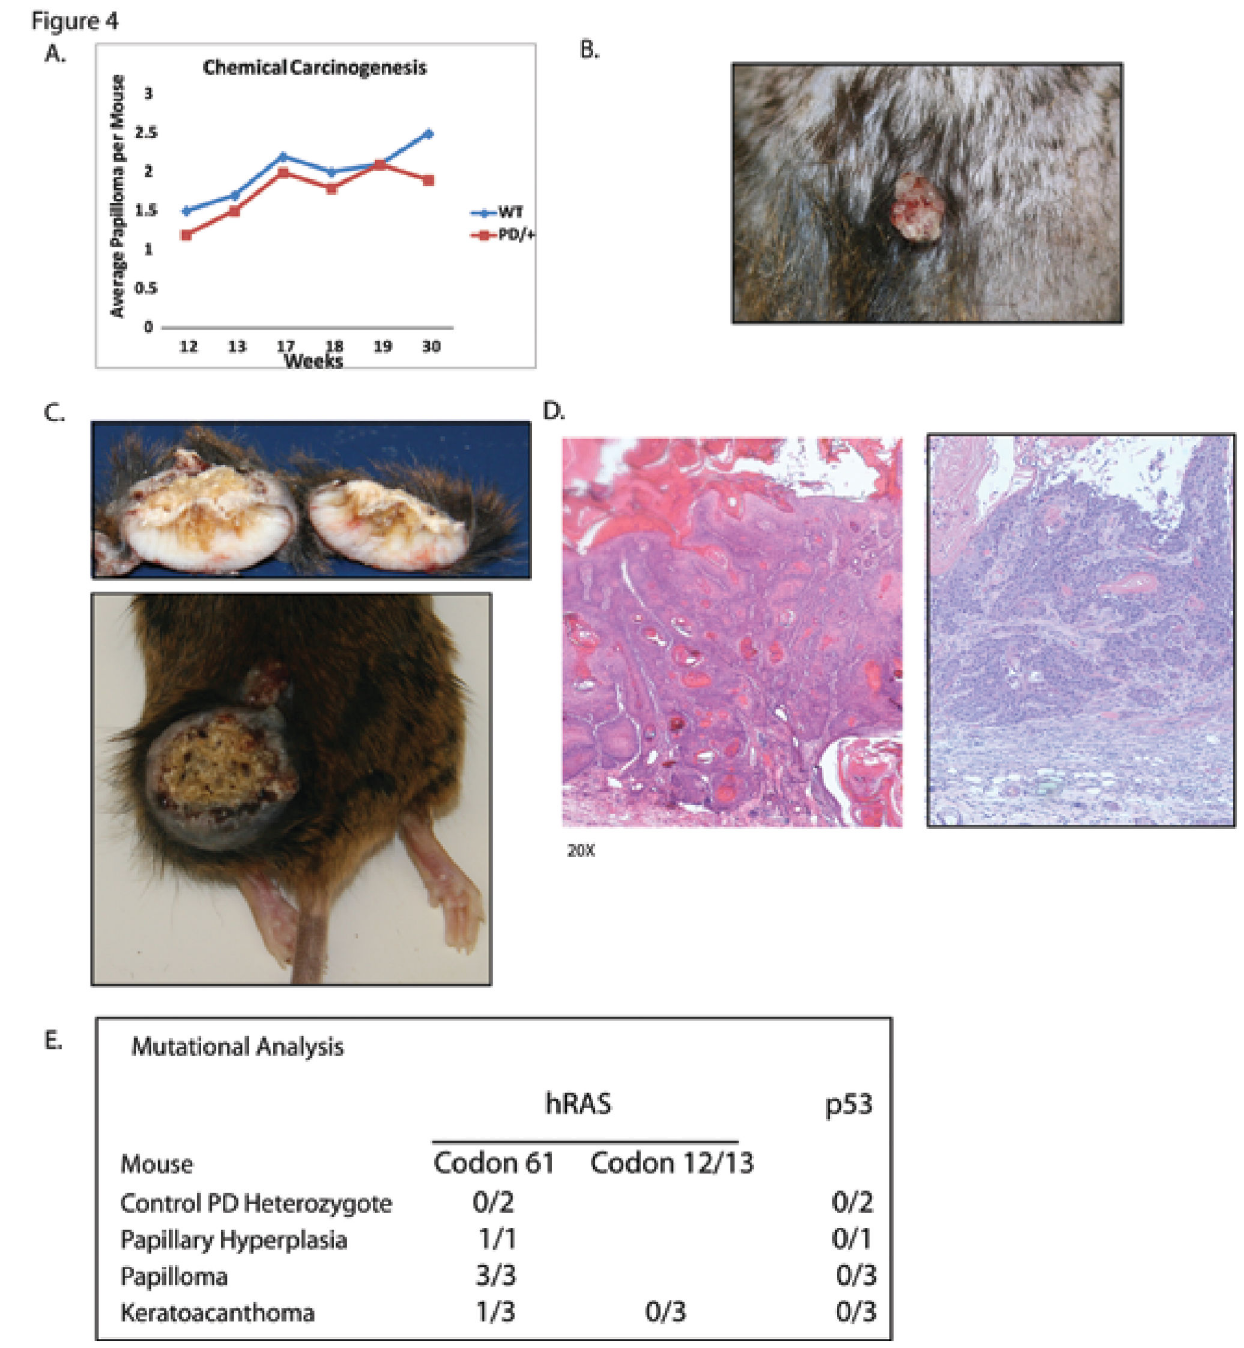
Figure 4. Keratoacanthoma development in the PD mice. Chemical carcinogenesis study in heterozygous PD and wild-type littermates. A. Papilloma formation in a PD heterozygote during TPA treatment shows no difference between experimental and control groups of mice. B. Clinical appearance of a typical papilloma. C. PD heterozygous mouse that has developed a typical keratoacanthoma showing a keratinaceous core and well-defined tumor. D. Histologic examination of keratoacanthomata from PD heterozygous mice showing classic appearance of these tumors. E. Mutational analysis of PD mice for Hras codons 12,13,61 and Tp53 .